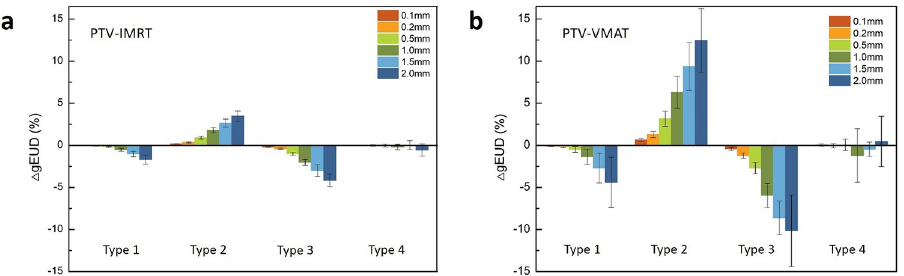
Fig 4. The gEUD variation in the PTV caused by MLC errors. 4(a) The gEUD variation in IMRT plans. 4(b) The gEUD variation in VMAT plans.